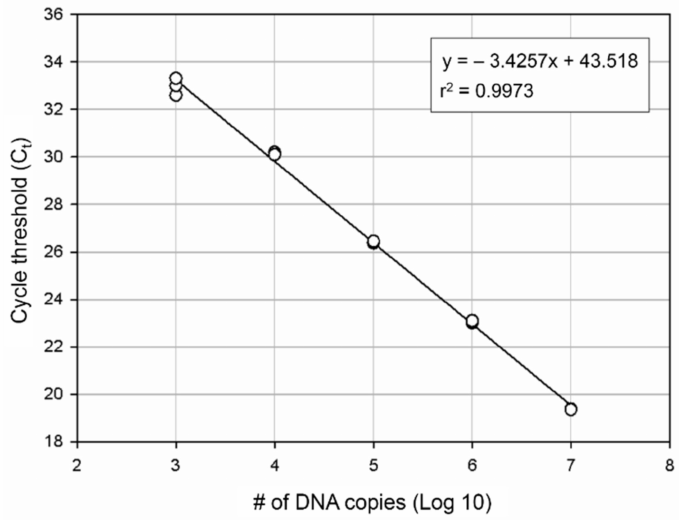
Figure 3. Determination of specificity of B. californica -specific primers by agarose gel electrophoresis of PCR products using species-specific primers for target and outgroup species. (1) 100 bp DNA ladder; (2–4) B. californica ; (5) Bugula neritina ; (6) Watersipora subtorquata ; (7) Tricellaria occidentalis ; (8) Schizoporella unicornis ; (9) Jellyella tuberculate ; (10) Bougainvillia muscus ; (11) Ectopleura crocea ; (12) Ascidiella aspersa ; (13, 14) DNA ladder; (15) Ciona robusta ; (16) Antedon serrata ; (17) Heliometra glacialis ; (18) Patiria pectinifera ; (19) Asterias amurensis; (20) Ophiactis savignyi ; (21) Ophiopholis mirabilis ; (22) Temnopleurus hardwickii ; (23) Phalacrocidaris japonica ; (24) Eupentacta quinquesemita ; (25) Protankyra bidentata ; (26) 100 bp DNA ladder.